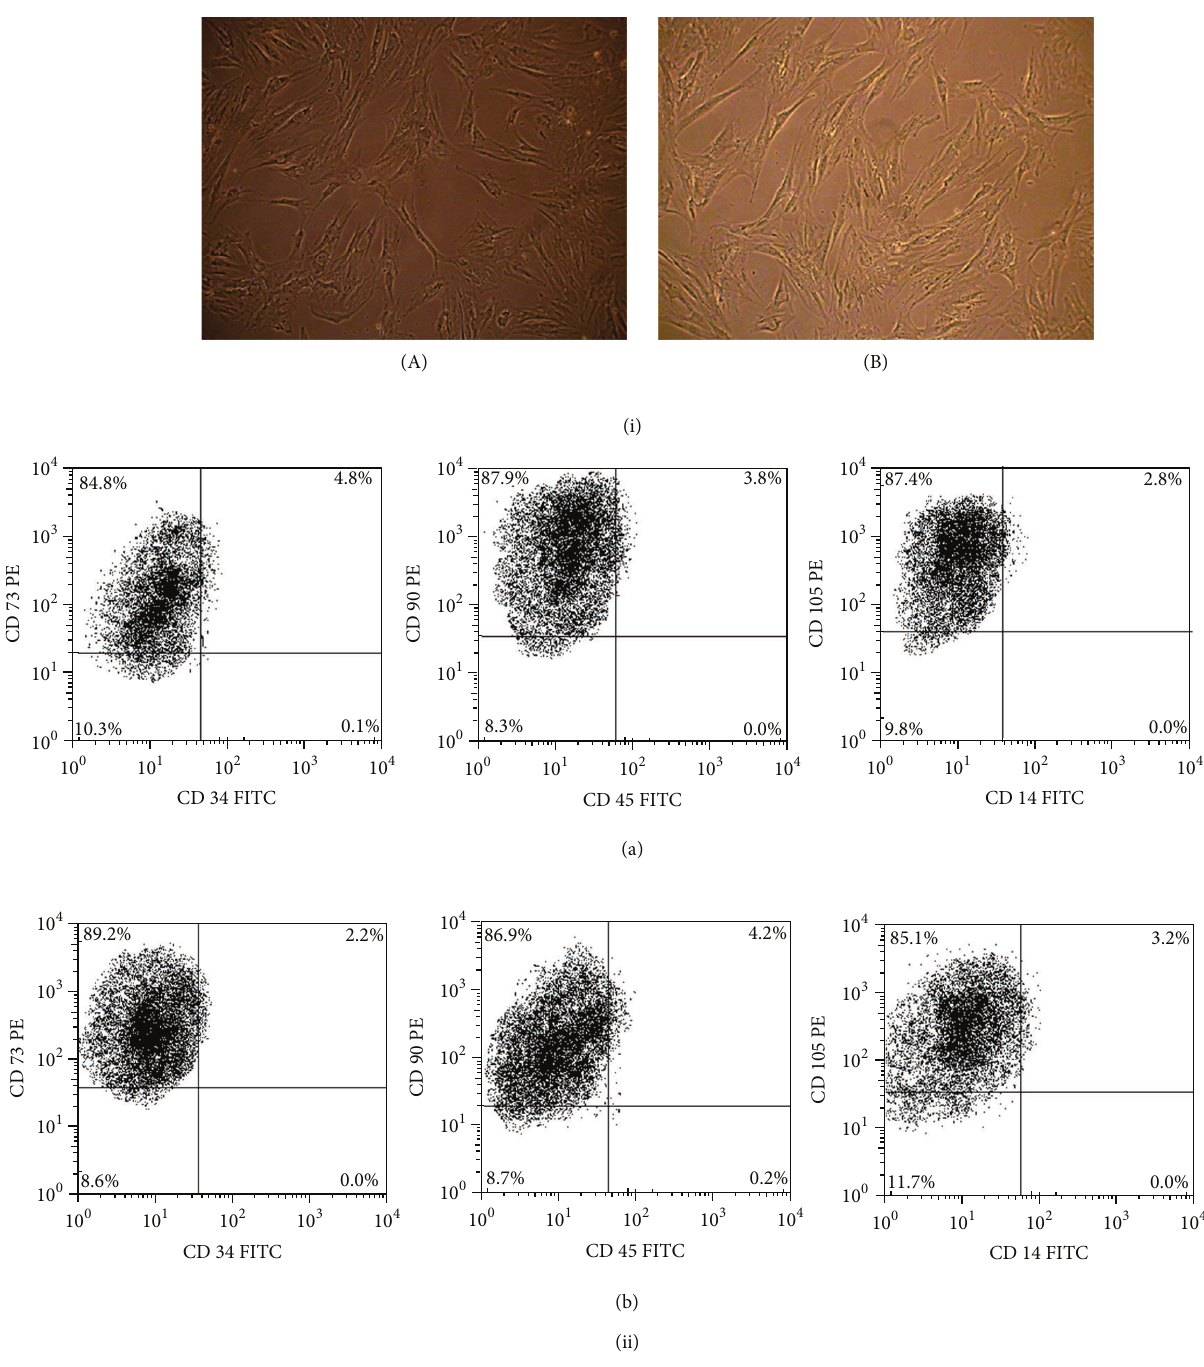
Figure 1: BM-MSC morphology and phenotype. (i) Fibroblastoid morphology of BM-MSC of (A) aplastic anemia patients and (B) control patients. (ii) Representative dot plots showing phenotype of BM-MSC of (a) aplastic anemia patients and (b) control